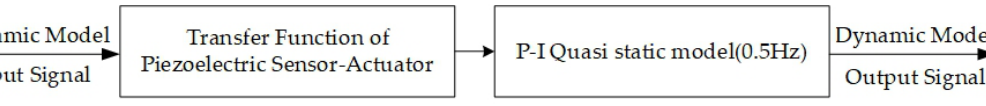
Figure 6. Dynamic Prandtl–Ishlinskii model.